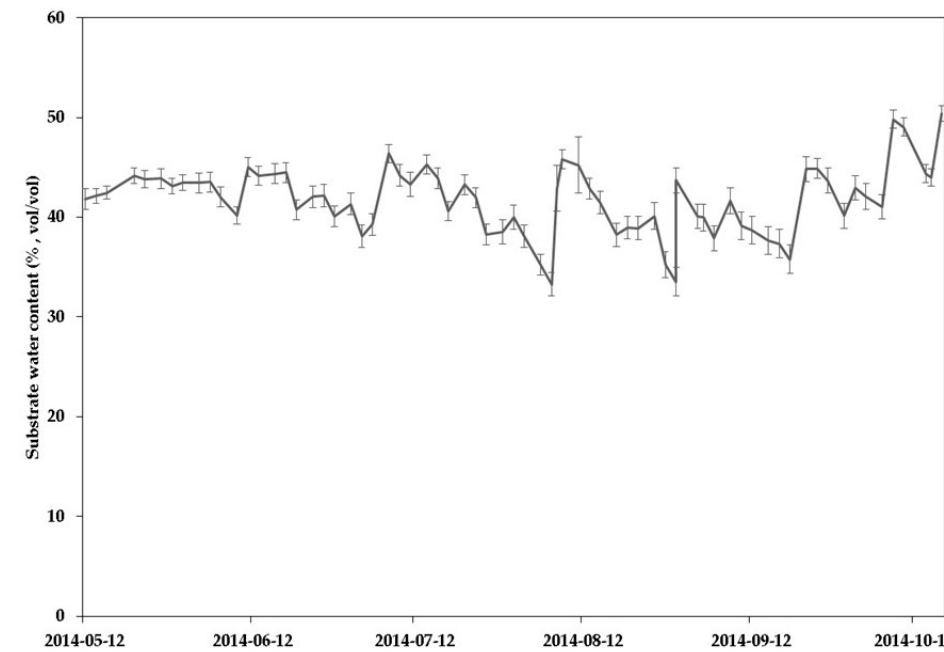
Figure 5. Variations in the mean water content of the substrate (%, volume/volume) during the first growing season of white spruce seedlings (1 + 0). Standard errors are indicated by bars (n = 6 containers).